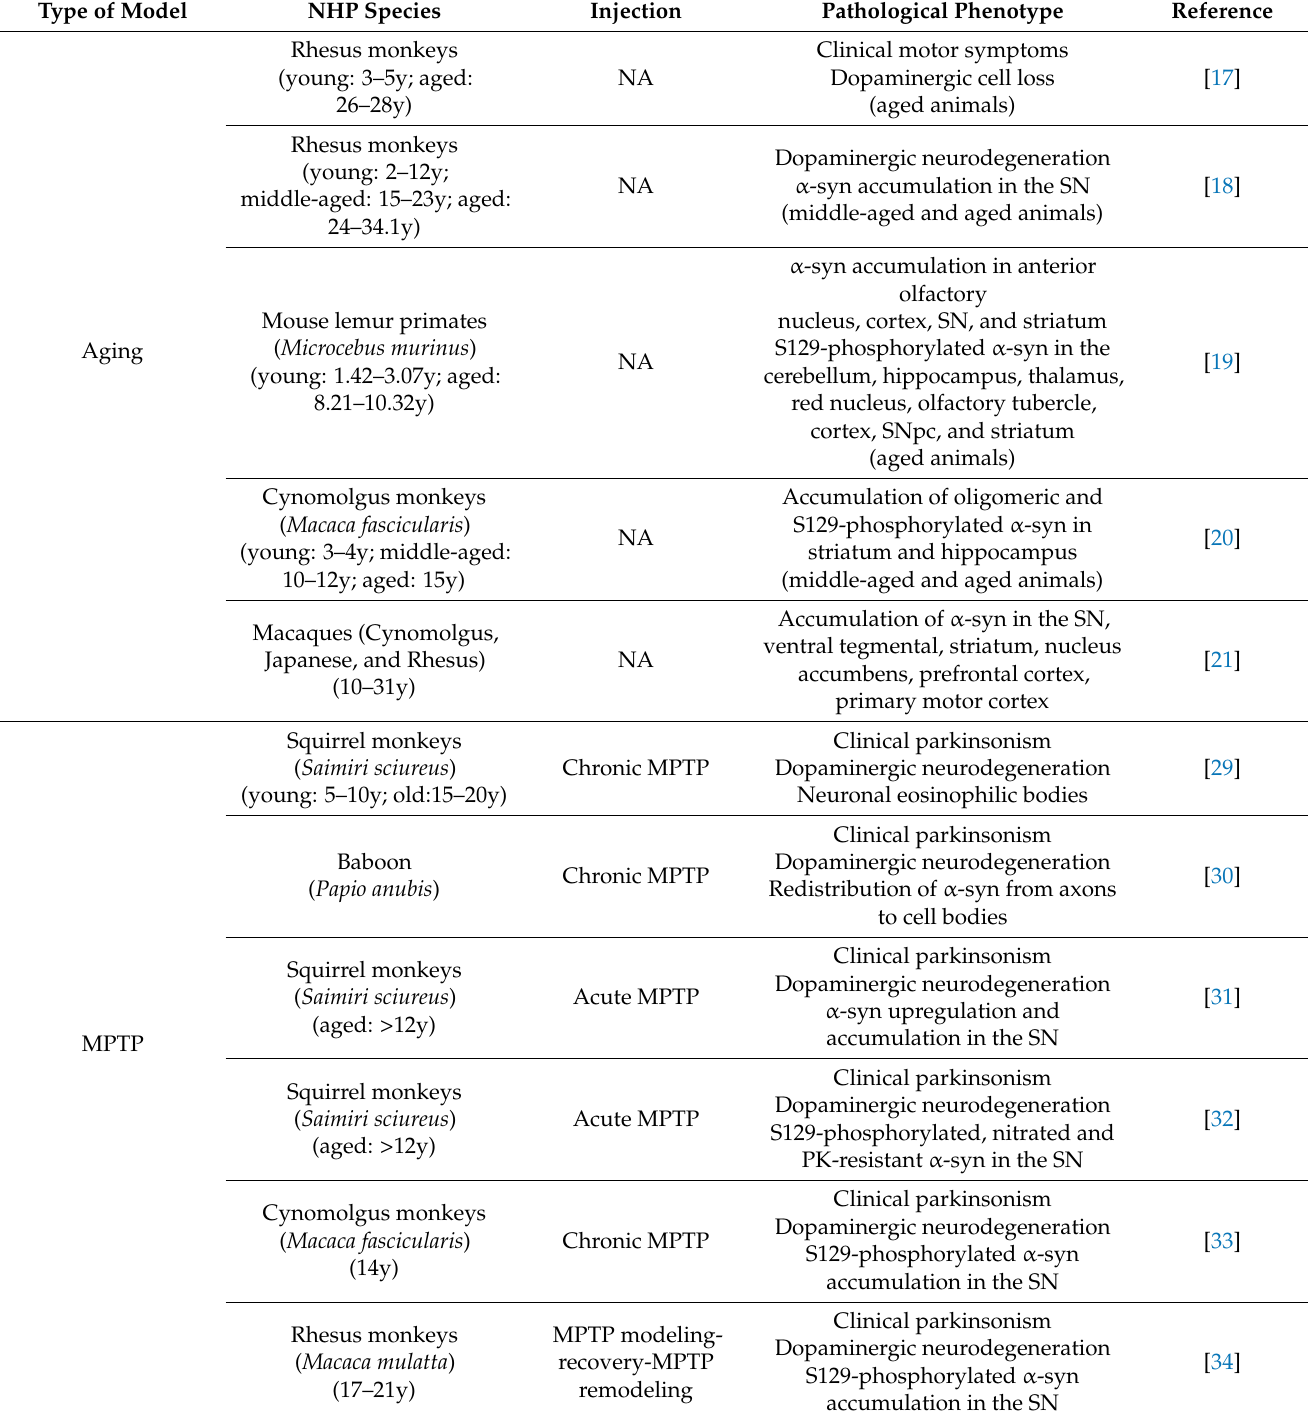
Table 1. Summary of non-human primate models of